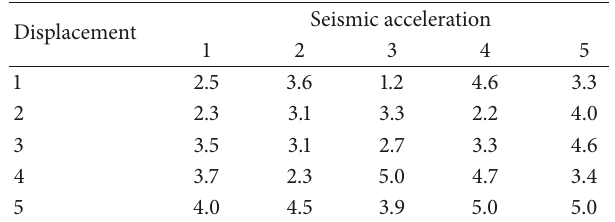
Table 5: Fuzzy control rule table of fuzzy control optimized by PSO (current).